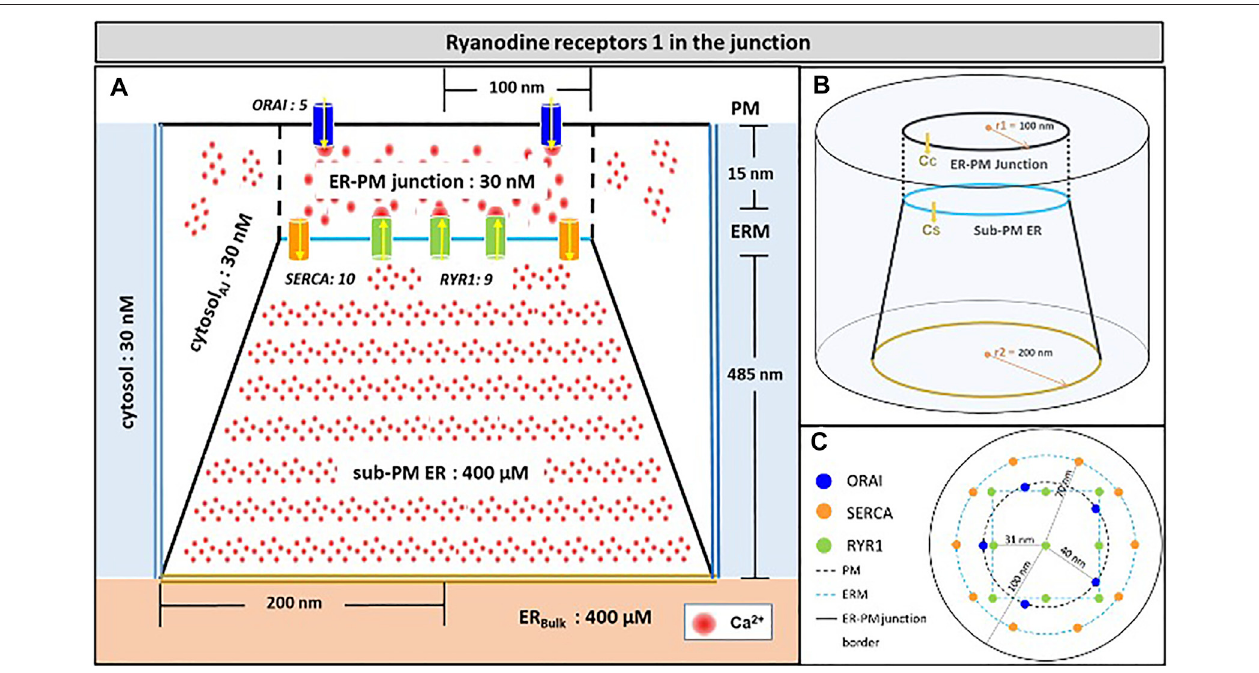
FIGURE 1 | Schematic representation of the model geometry of the ER-PM junction and sub-PM ER used to investigate the origin of the Ca 2+ microdomains in TcellswithnineRYR1insidethejunction (A) Frontaldiagramshowingthedimensionsoftheconethatrepresentsthesub-PMER,ofthejunctionandoftheportionofthe cytosol considered in the simulations. ORAI1 channels are in blue, SERCA pumps in orange and RYR1 in green. Plain lines represent membrane boundaries; dashed lines, fi ctitious limits between the junction and the cytosol and double lines indicate the limits of the simulated system. The resting Ca 2+ concentrations considered as initial conditions and boundary conditions in the two compartments are indicated. (B) 3D view of the model geometry (C) Upper view of the positions of the ORAI1 channelsonthePM,inblue,andoftheSERCApumpsandRYR1(inachessboardmanner)ontheERM,inorangeandgreenrespectively.Nottoscale.Thisgeometryis based on McIvor et al. (2018). See text for